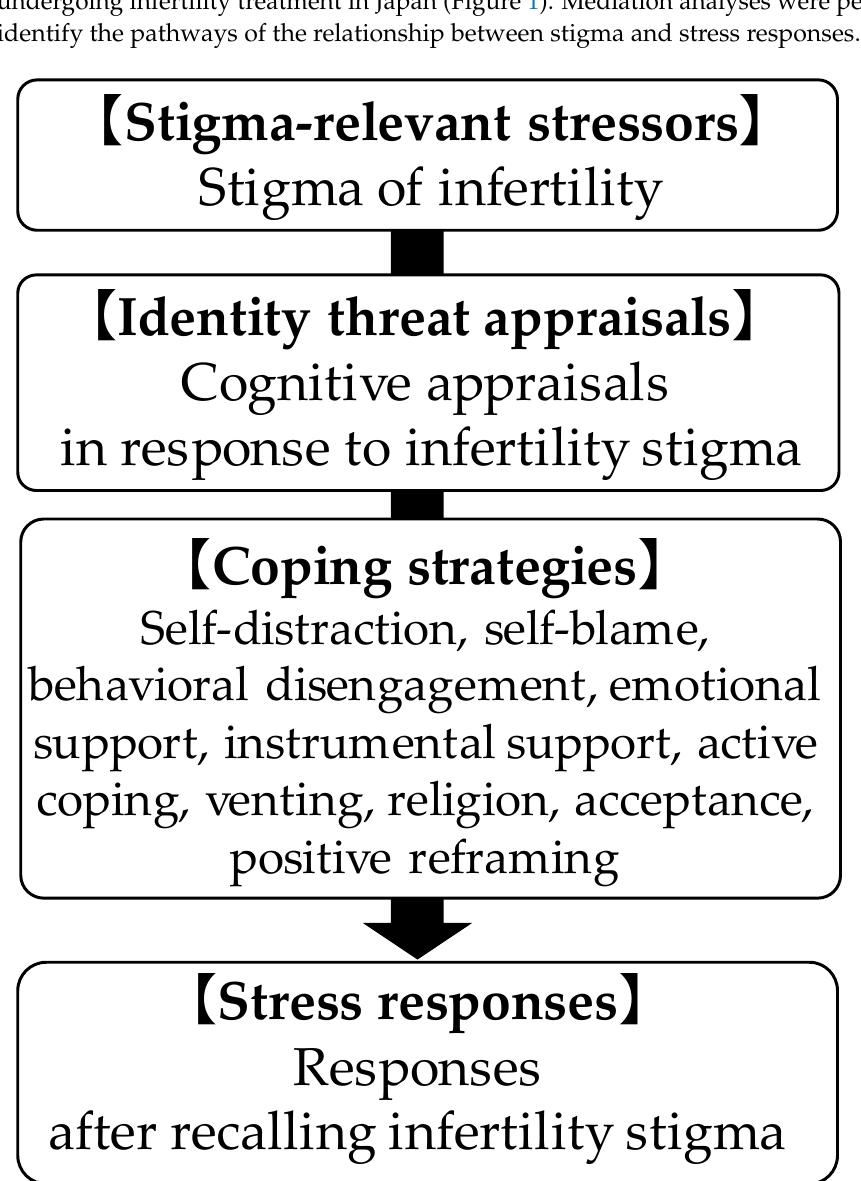
Figure 1. Conceptual hierarchical framework of predictors of stress responses.